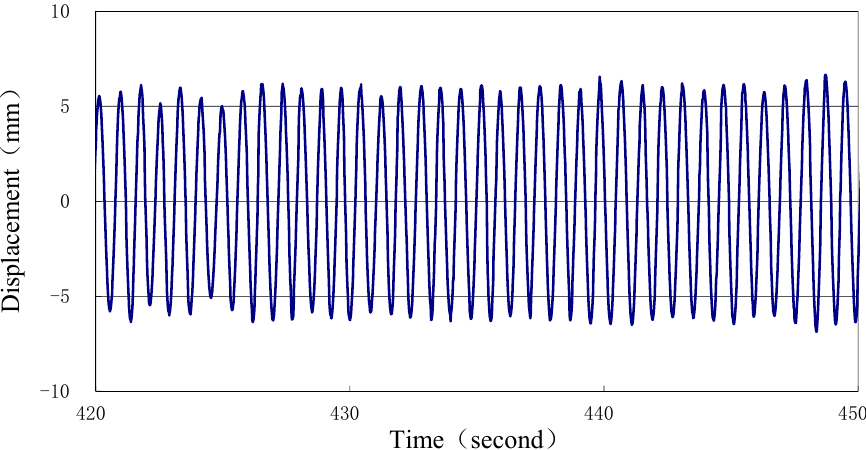
Figure 6. Displacement curve of the top deck when the accident occurred.